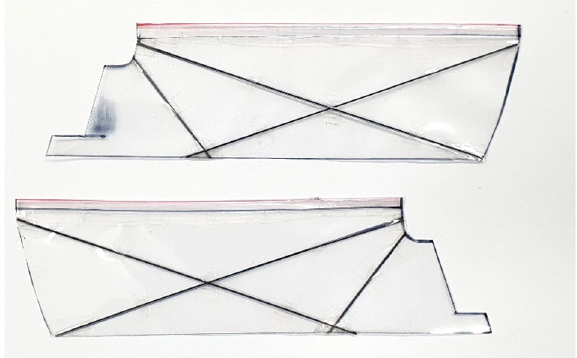
Figure 2. Picture of the wings used.